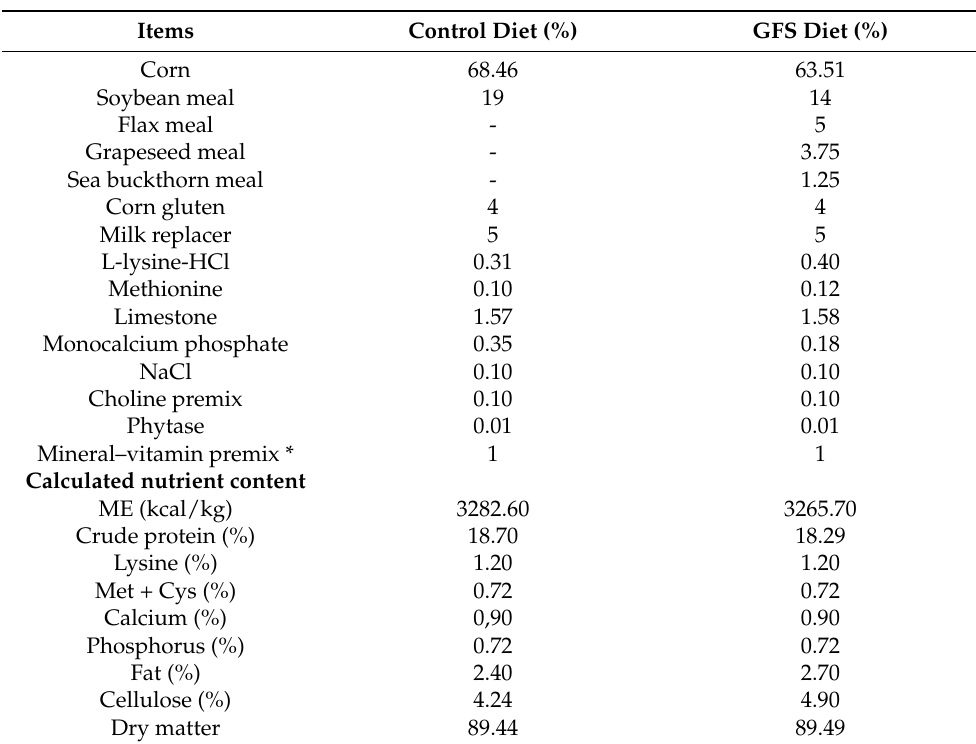
Table 2. Composition and calculated nutrient content of experimental diets